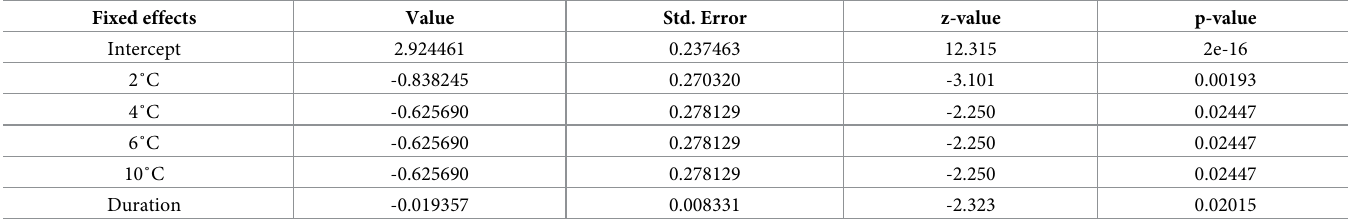
Table 2. Fixed-effects coefficients of a mixed-effect binomial model of the impact of temperature and duration of the survival of male Aedes albopictus on day 15 post-exposure. Fixed